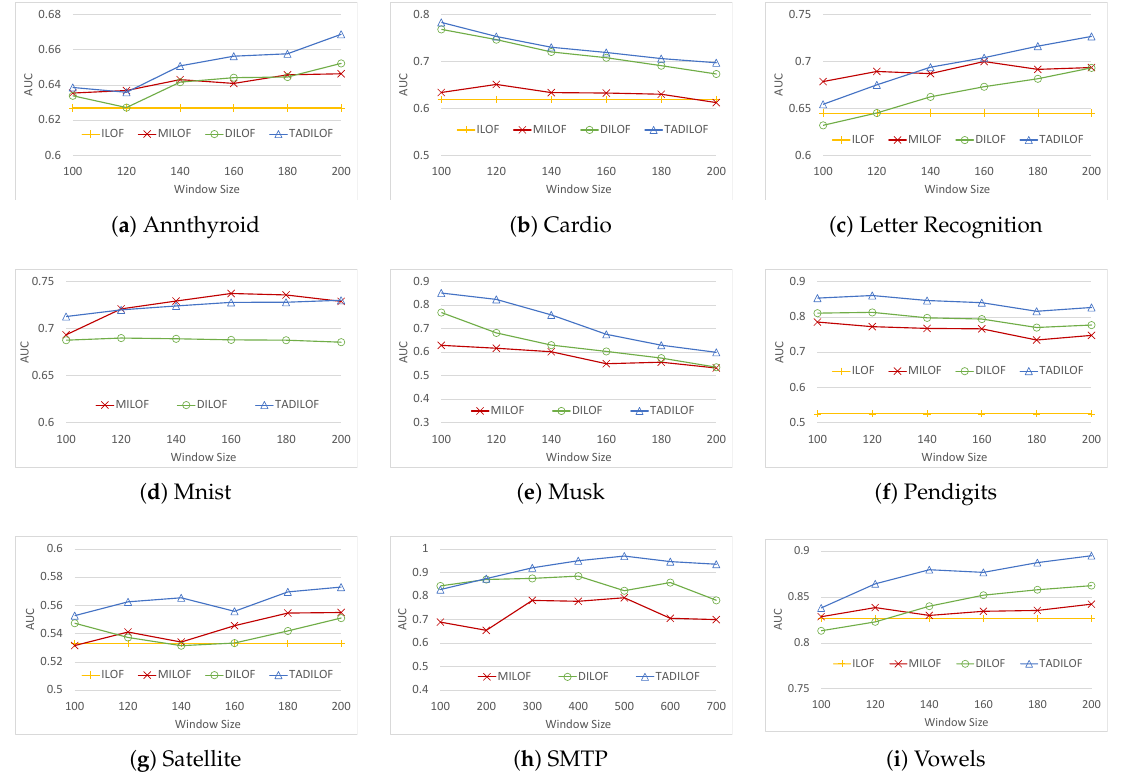
Figure 6. AUC on various datasets with different window sizes and K =